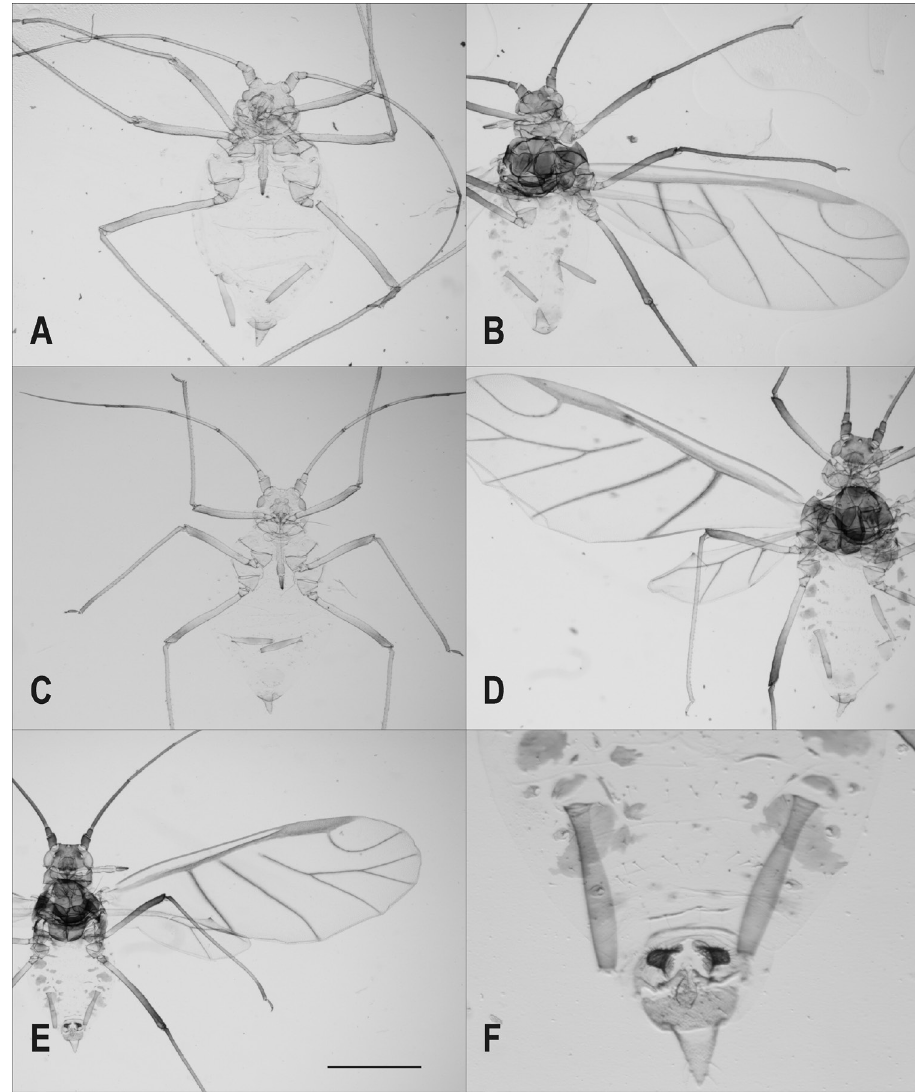
Figure 2. Delfinoia peruviana (Essig). A–B specimens from Peru, previously labelled Utamphorophora peruviana (Essig) C–F specimens from Argentina, previously labelled Wahlgreniella australis Delfino A, C apterous viviparous females B, D alate viviparous females E–F male. Scale bar: A–D 1 mm; E, F 0.21